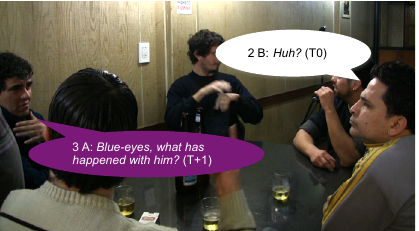
Figure 9. ‘What has happened with Blue-eyes (sign name)? I haven’t seen him’ , Person A (left) asks Person B (right) about another person, line 1 (T-1).